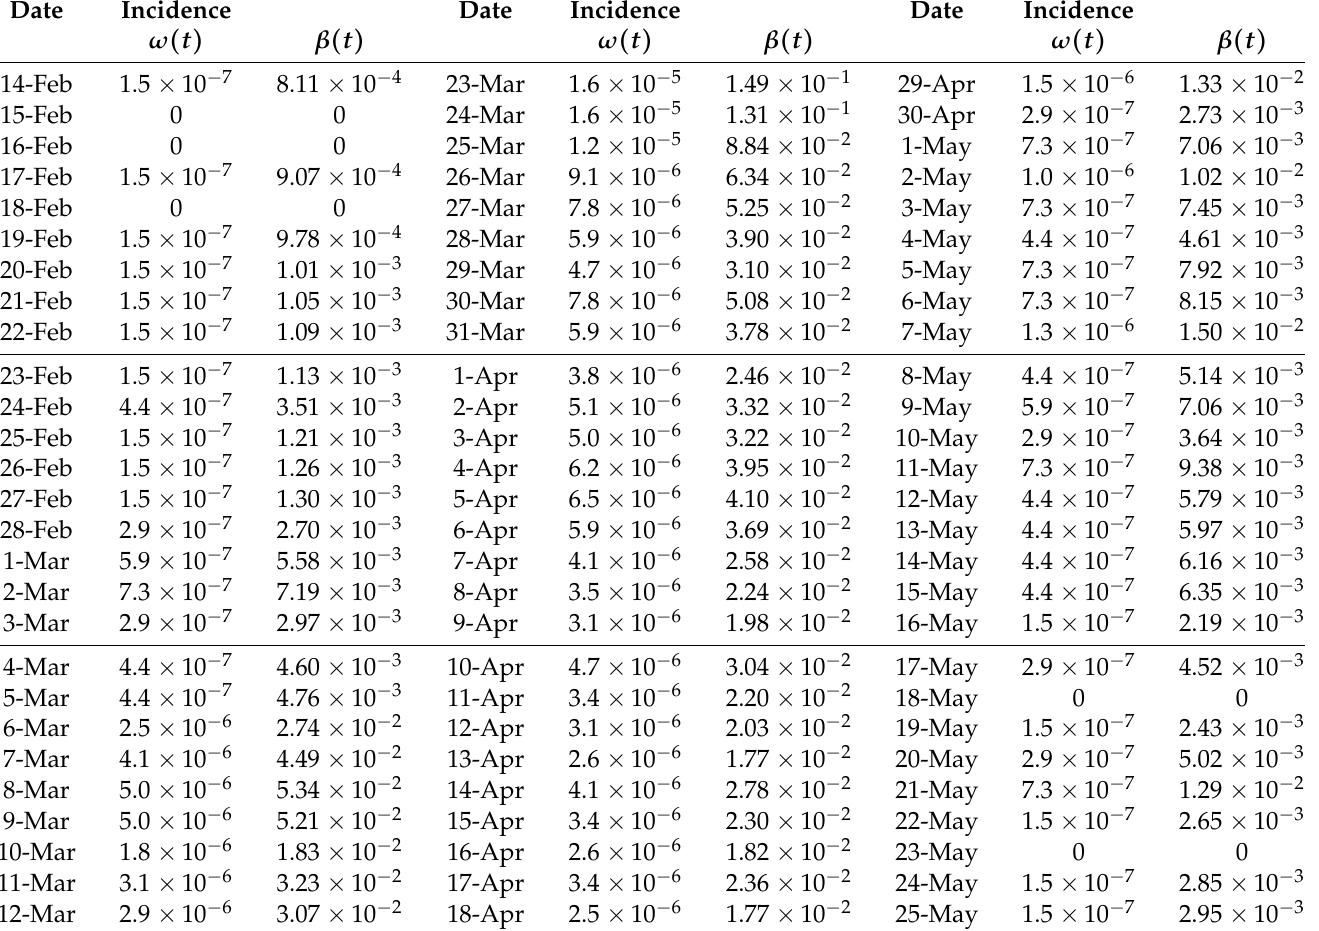
Table A3. Estimates of β ( t ) using incidence data from the 2003 Severe Acute Respiratory Syndrome (SARS) epidemic in Hong